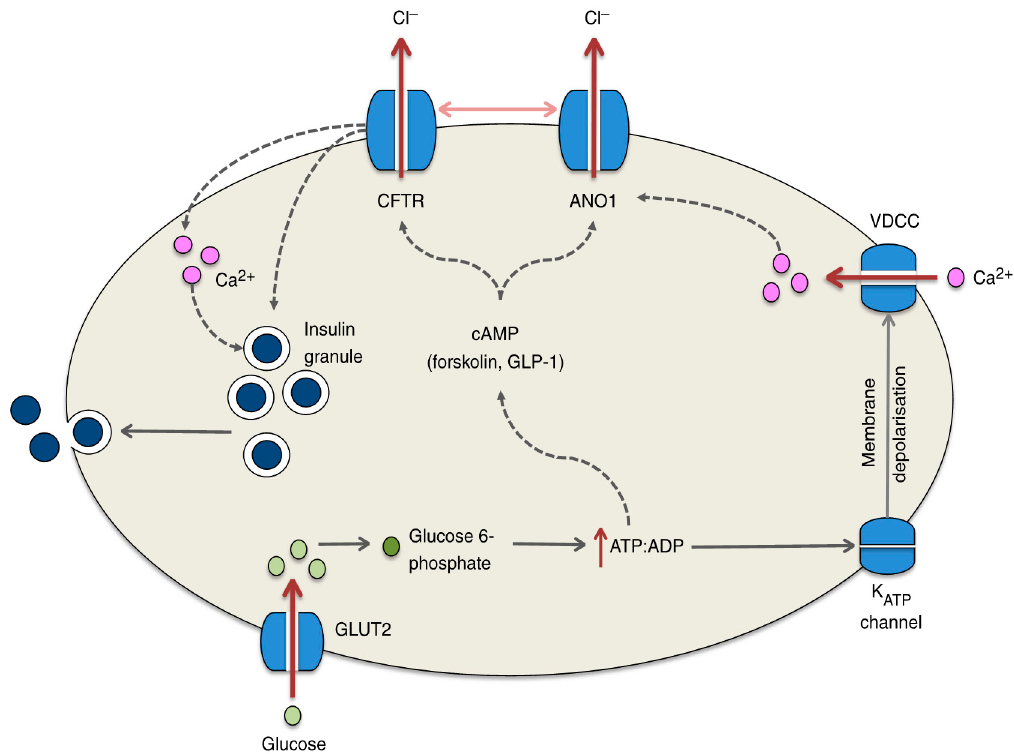
Figure 2. Potential mechanisms by which CFTR regulates insulin secretion from the β cell. Glucose enters the β cell through GLUT2 and is rapidly metabolized to glucose 6-phosphate, ultimately resulting in the generation of ATP, which causes the ATP-sensitive K ATP channel to close. Membrane depolarization and the opening of voltage-dependent Ca 2+ channels (VDCCs) ensue and calcium fluxes into the cell, resulting in insulin exocytosis. Recent studies have suggested that this process is hampered in the absence of CFTR, which may result from defects in ATP-generated cAMP activation of the CFTR channel. Indeed, pronounced reductions in insulin secretion are observed in response to forskolin- and GLP-1-stimulated increases in the cAMP level. In addition, evidence suggests that CFTR (in conjunction with ANO1) may be involved in the priming of the insulin granule or in the regulation of the calcium flux within the β cell. The regulation of ANO1 by CFTR is denoted by the horizontal arrow between the two channels; dotted lines represent proposed mechanisms yet to be confirmed. This figure has been published in “Koivula, F.N.; McClenaghan, N.H.; Harper, A.G.; Kelly,